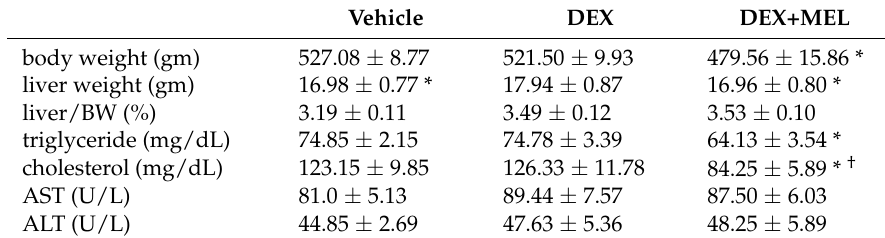
Table 1. Weight and laboratory data (SEM).